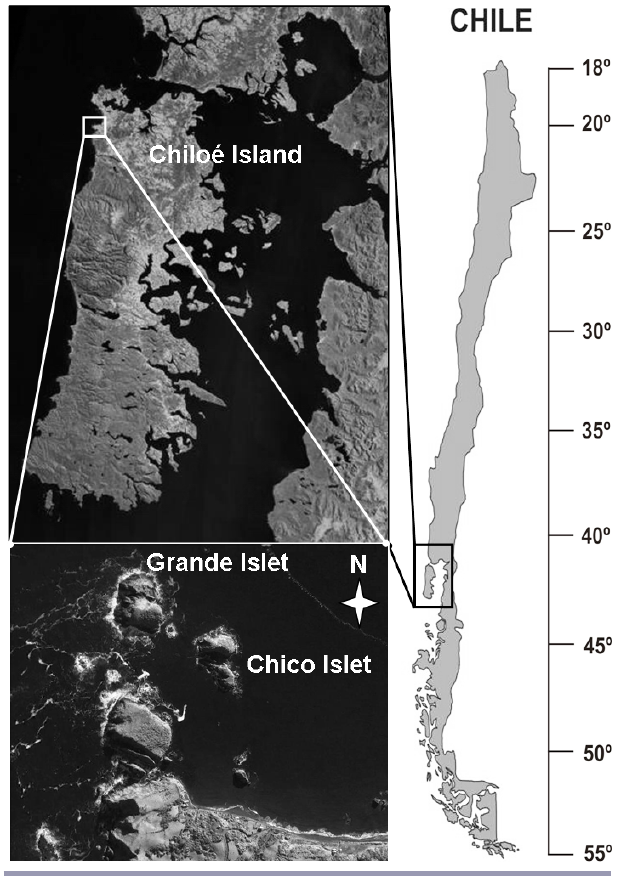
Fig. 1 . Map of the Puñihuil Islets, Chiloé, Chile, showing the location of the mixed colony of penguins in Chico Islet and Grande